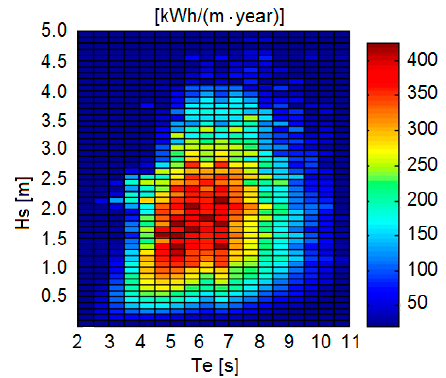
Figure 11. Scatter table of extractable energy along Maltese coasts, using the SWAN model.